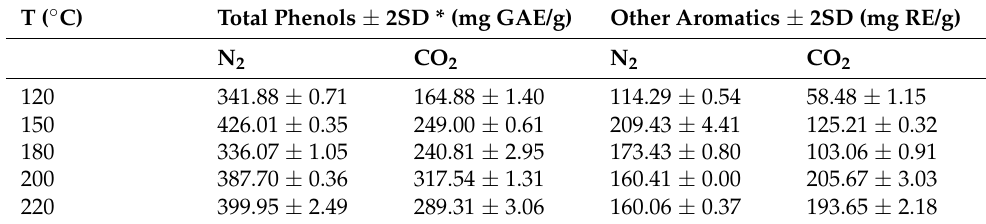
Table 2. The influence of temperature on lignin